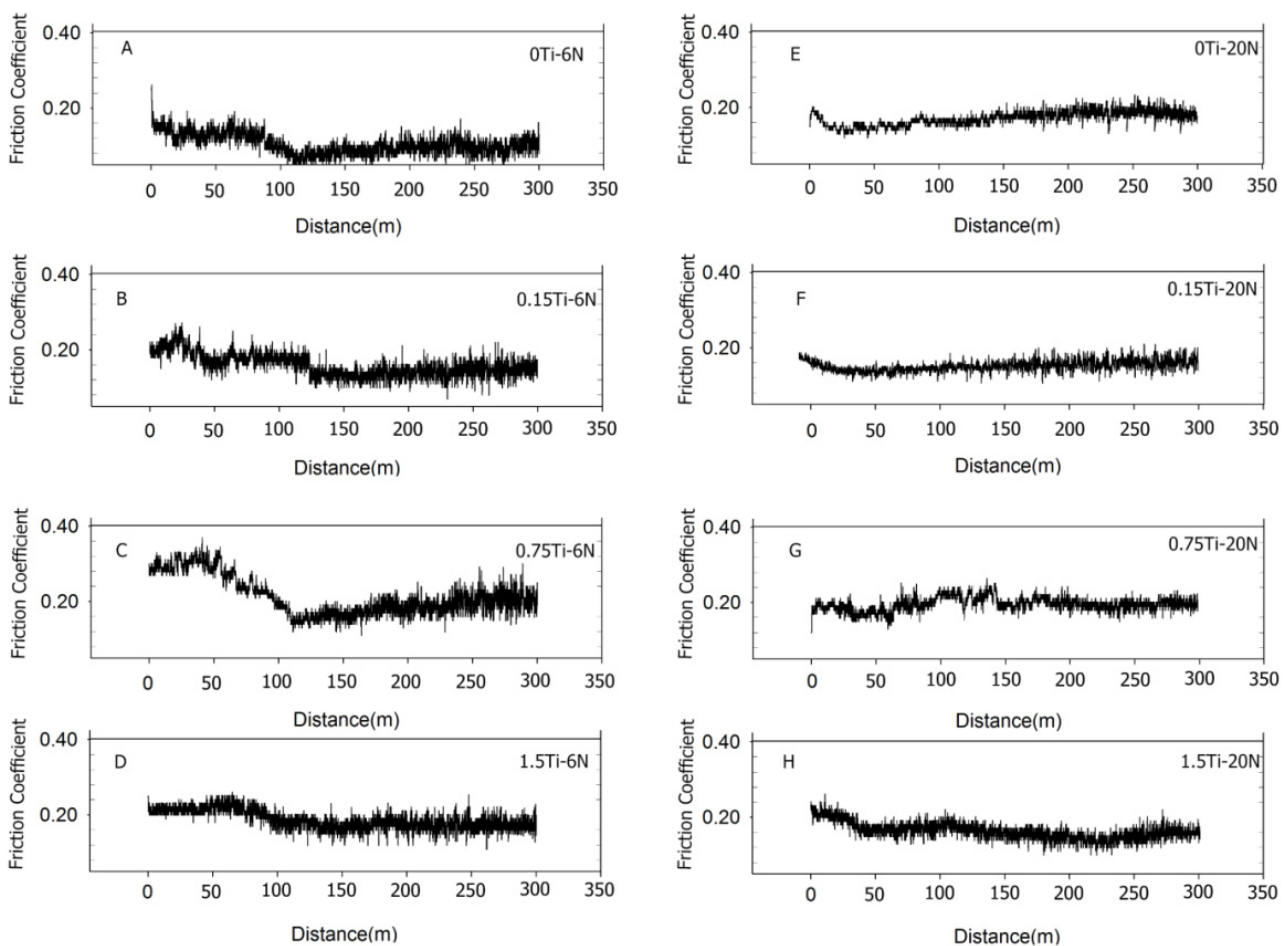
Figure 5. Representative graphs of difference of friction coefficient as a function of sliding distance for 6 and 20 N normal forces; ( A ) the 0Ti sample at 6 N normal force; ( B ) the 0.15Ti sample at 6 N normal force; ( C ) the 0.75Ti sample at 6 N normal force; ( D ) the 1.5Ti sample at 6 N normal force; ( E ) the 0Ti sample at 20 N normal force; ( F ) the 0.15Ti sample at 20 N normal force; ( G ) the 0.75Ti sample at 20 N normal force; and ( H ) the 1.5Ti sample at 20 N normal load.